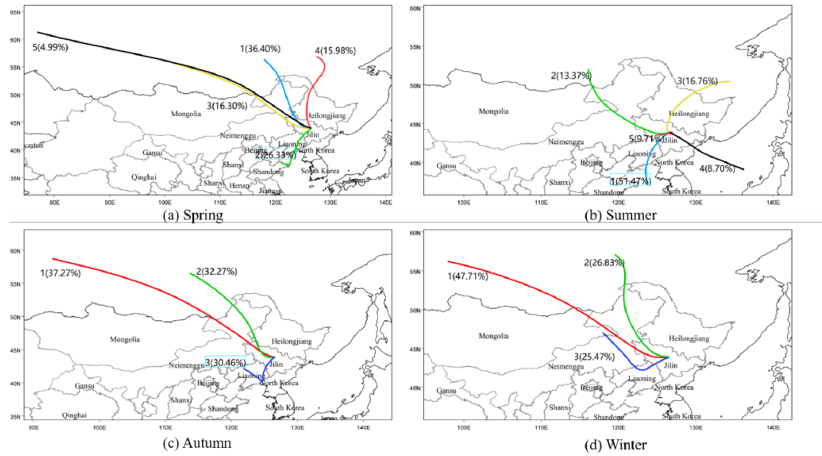
Figure 10. The trajectory clustering results of four spring, summer, autumn, and winter seasons in eastern Jilin Province in 2019. In ( a ), the trajectories are divided into five clusters: cluster 1 is in blue; cluster 2 is in green; cluster 3 is in yellow; cluster 4 is in red; cluster 5 is in black. In ( b ), the trajectories are divided into five clusters: cluster 1 is in blue; cluster 2 is in green; cluster 3 is in yellow; cluster 4 is in black; cluster 5 is in red. In ( c , d ), the trajectories are divided into three clusters: cluster 1 is in red; cluster 2 is in green; cluster 3 is in blue.